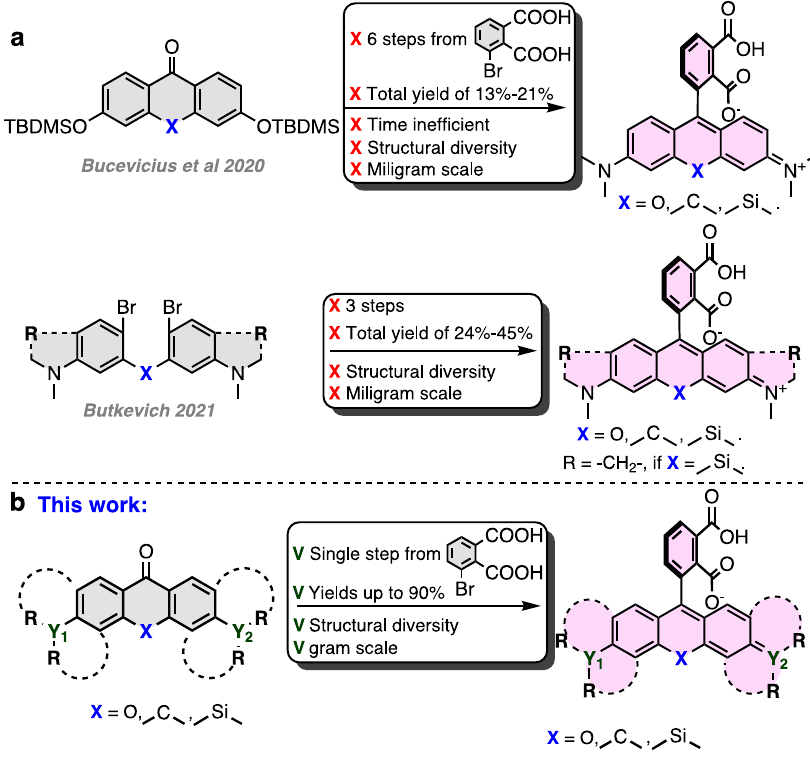
Fig. 1 | Synthetic approaches to 4-carboxyrhodamines and their analogs. a Previous work: synthesis of 4-carboxyrhodamines through fl uorescein conversion to rhodamine and through bis-aryllanthanum species. b This work: synthesis of 4-carboxyrhodamines by single protective group free